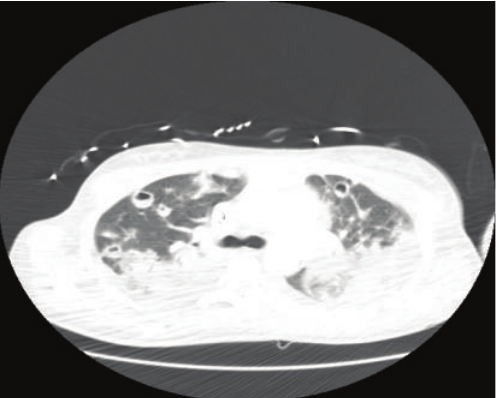
Figure 4: Chest tomography showing development of pulmonary infiltrates.